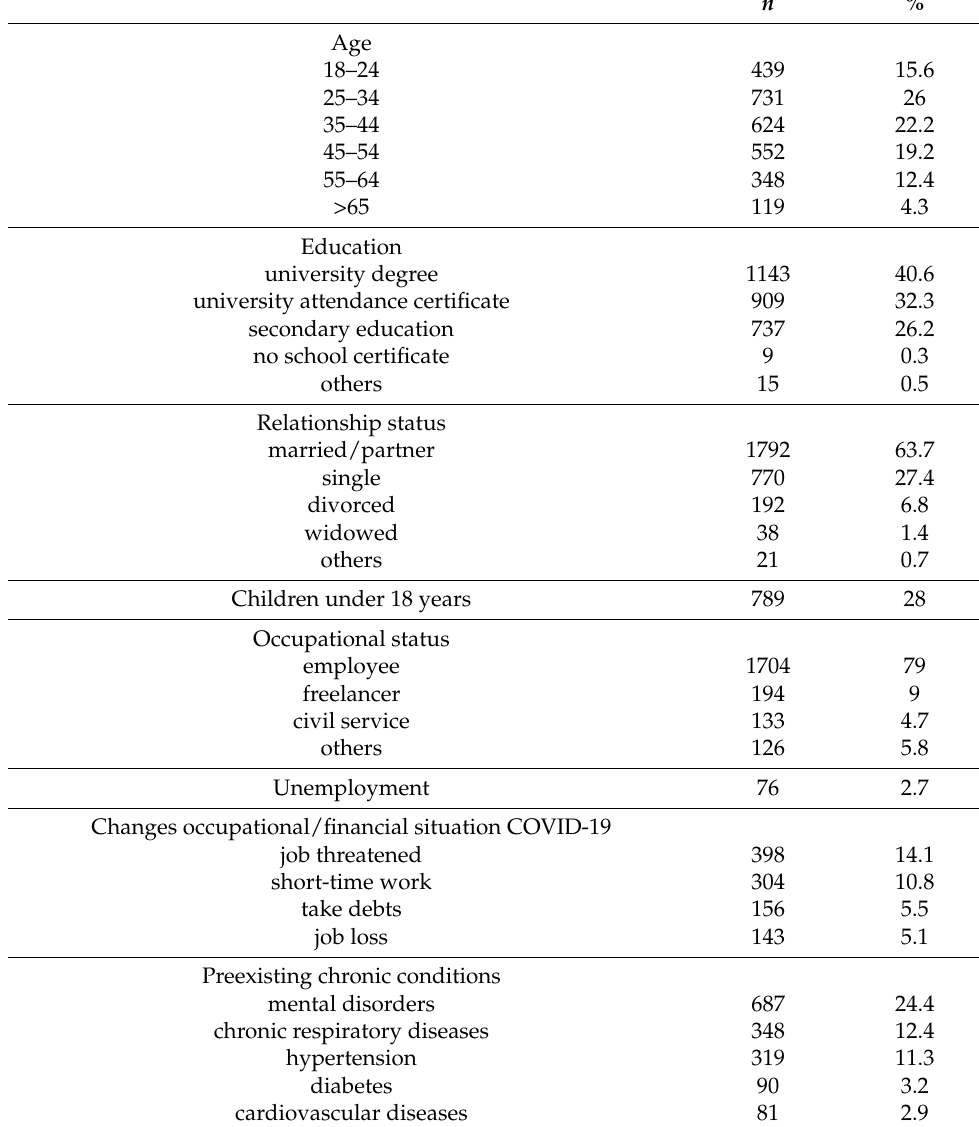
Table 1. Sociodemographic data.